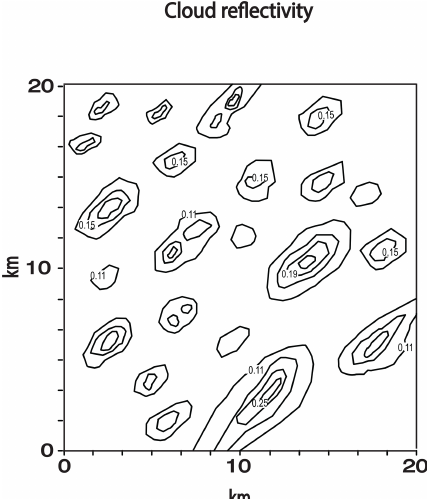
Figure 6. Same as Fig. 2 but in the control run.